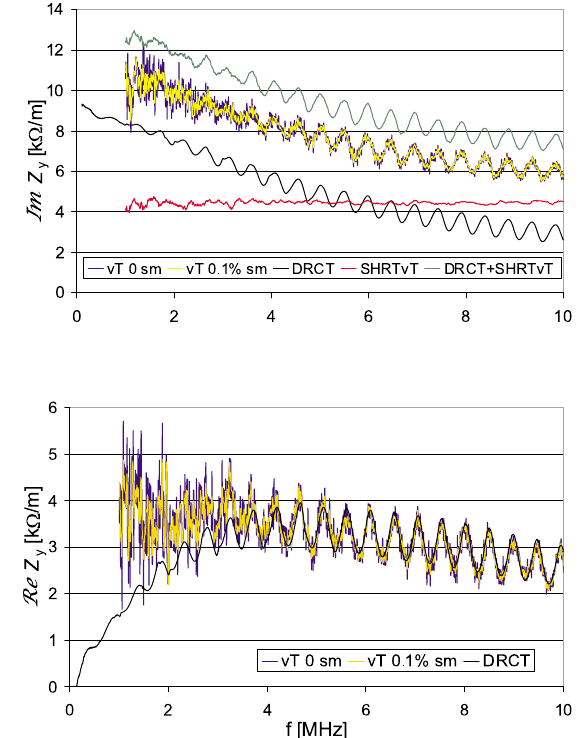
FIG. 23. (Color) Vertical impedance of kicker system with magnet K11.